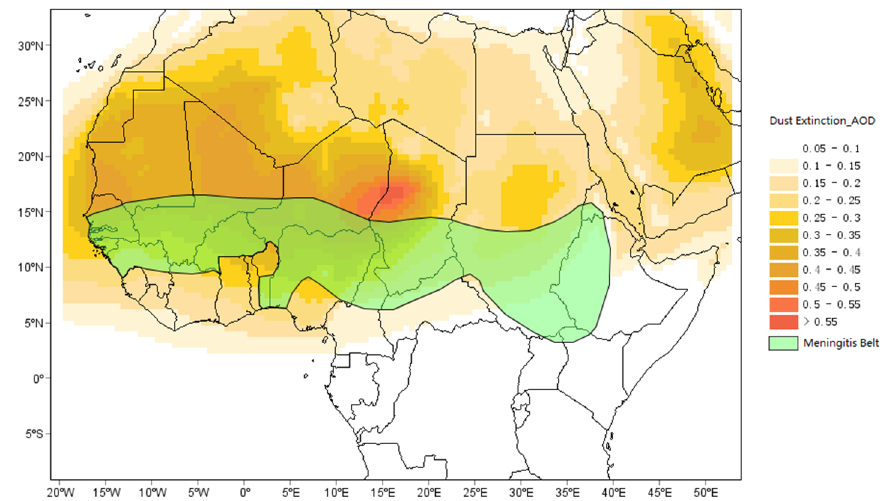
Figure 6. Geographical distribution of meningitis belt [208] and reanalyzed satellite observed aerosol optical depth of dust extinction (MERRA-2, Range from January 1980 to December 2015) over North Africa.